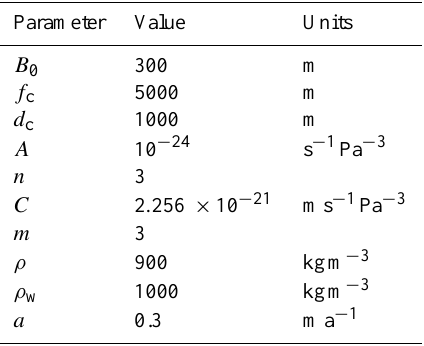
Table 1. Model parameters. The parameters B 0 , f c and d are geo- metrical parameters that affect the shape of the bedrock (see Eq. 3). A and n are the rate factor and the stress exponent of Glen’s flow law, respectively, C and m are the basal slipperiness and the stress exponent of Weertman’s sliding law, and ρ and ρ w are the specific densities of ice and ocean. The variable a is the surface mass bal- ance in the units of ice equivalent. The number of days in a year is 365.25. Parameter Value Units